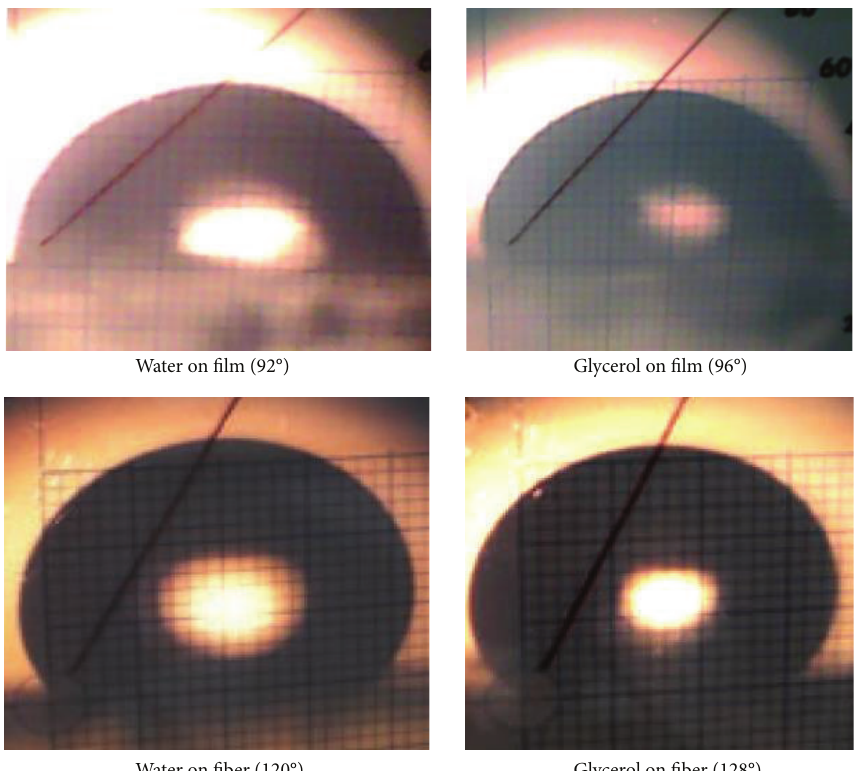
Figure 4: The profiles of a droplet on the polymer 2 a surface.